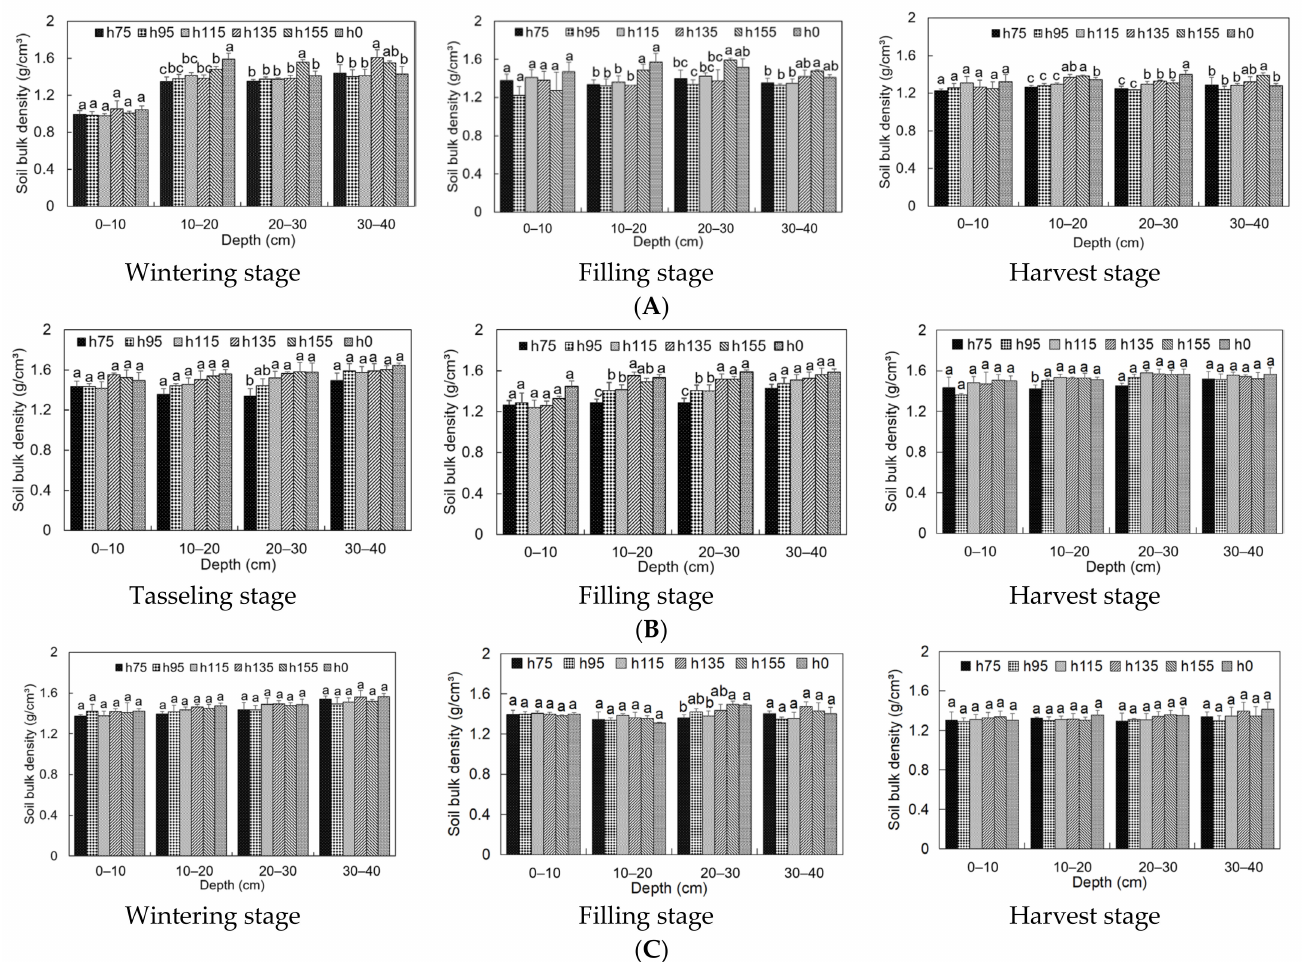
Figure 7. Bulk densities of soil at different depths in key stages of winter wheat in the first growing season (WW1) ( A ), summer maize (SM) ( B ), and winter wheat in the second growing season (WW2) ( C ). (Different letters (a–d) stand for significant difference at p < 0.05; error bars represent standard deviations from the